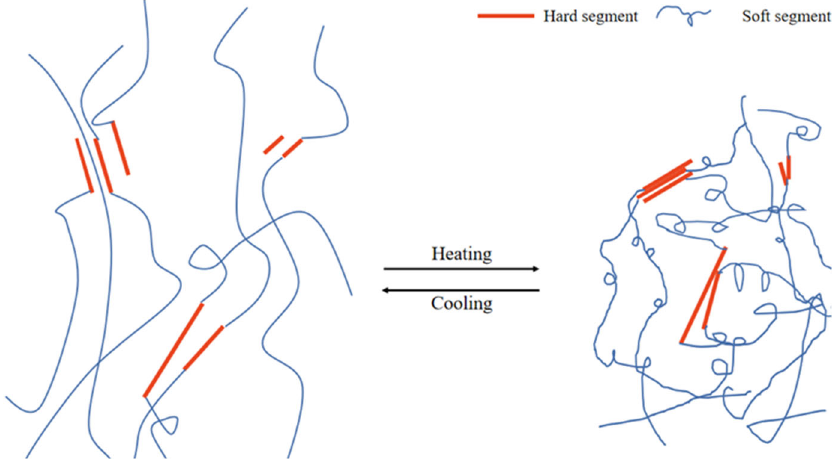
Figure 11. Polyurethane heating and cooling